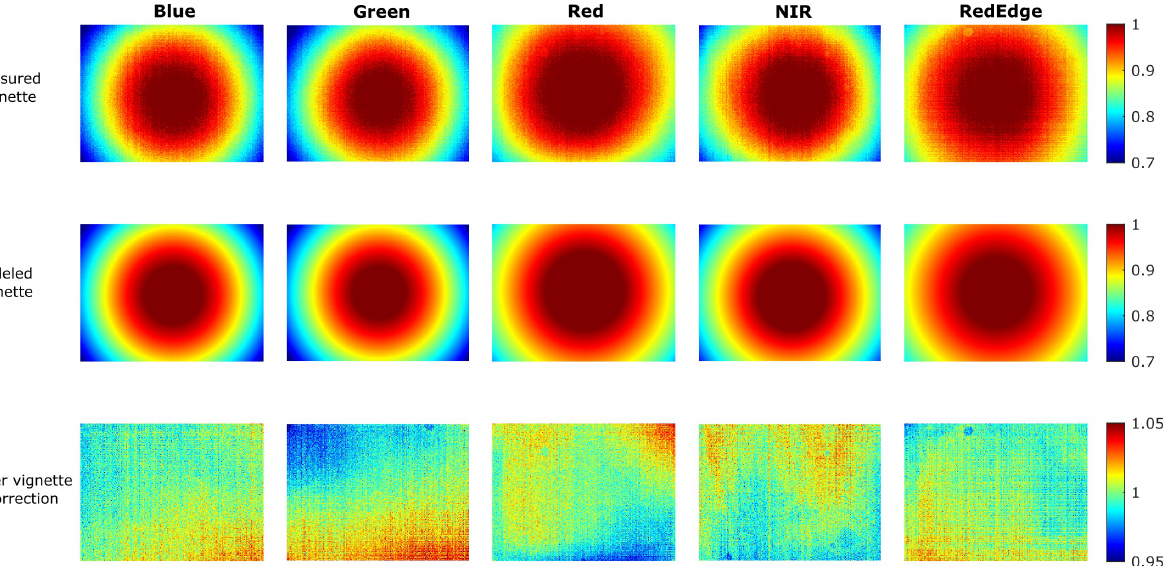
Figure 13. Measured vignette, modeled vignette, and results of vignetting correction for each band of the multispectral